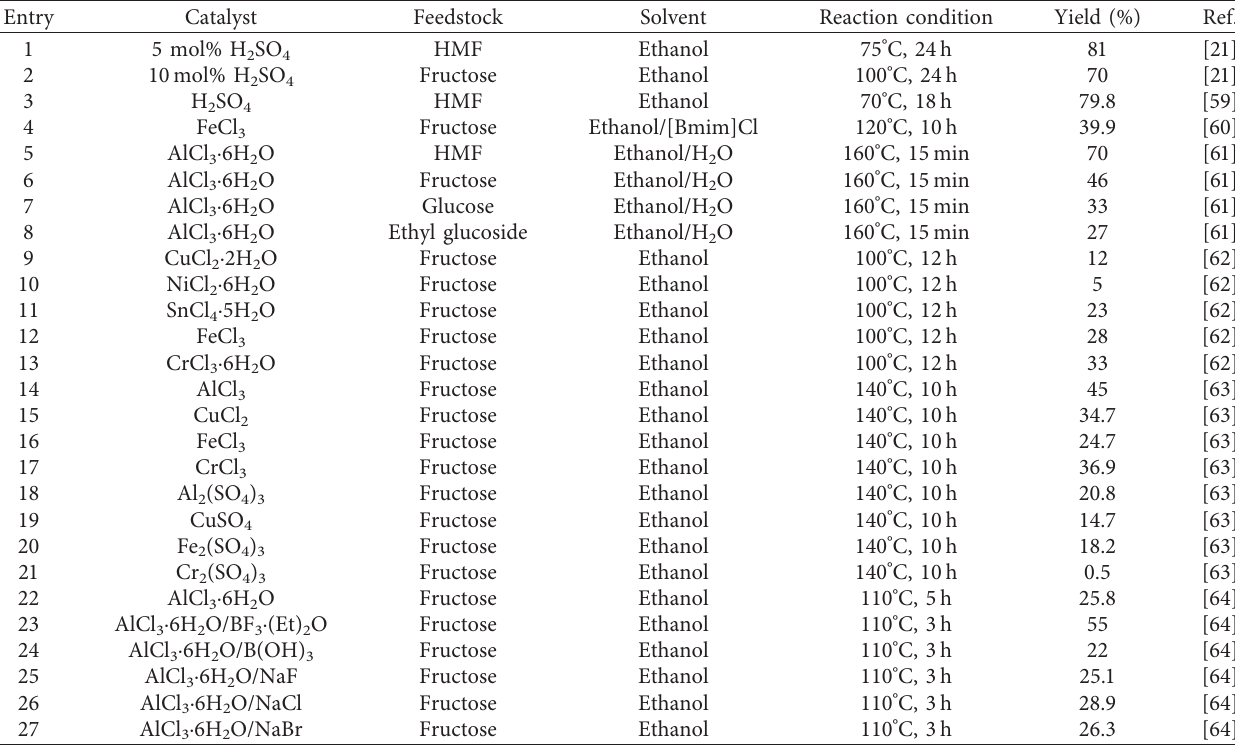
Table 2: Various homogeneous catalysts used for EMF